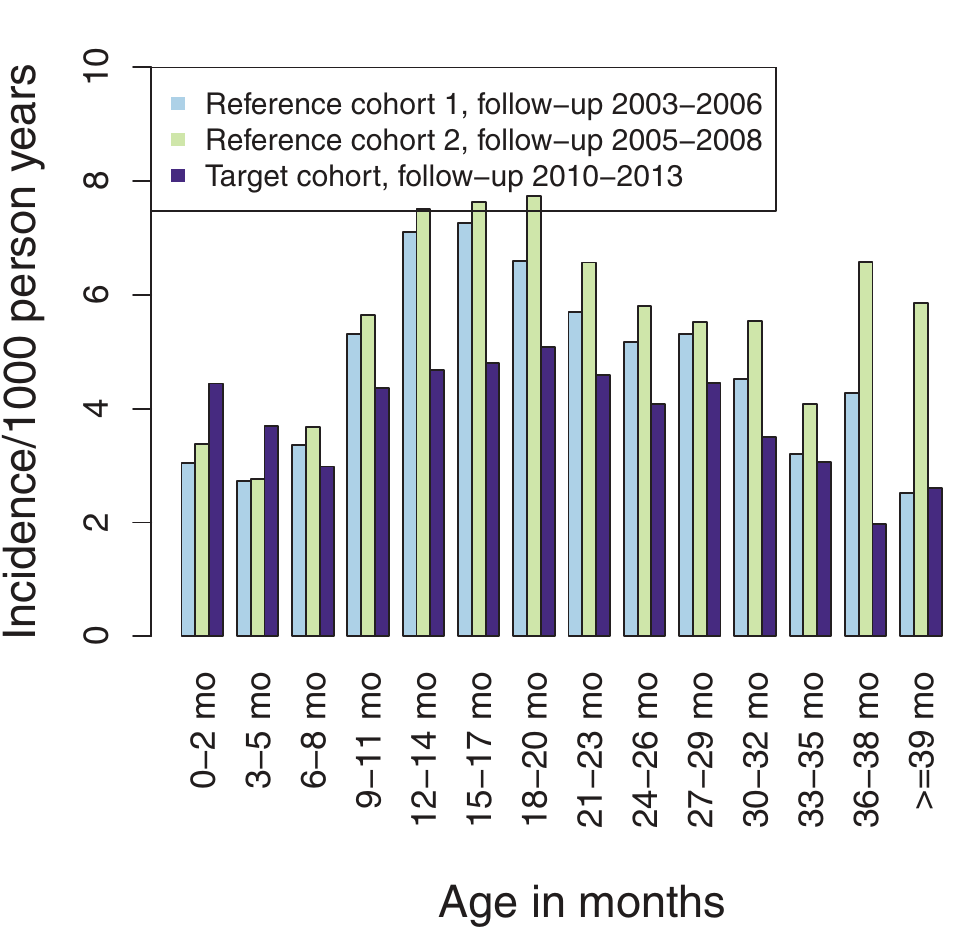
Fig 6. The incidence of hospital-treated primary pneumonia (HTPP) by age in vaccine-eligible target cohort compared to reference cohorts before introduction.